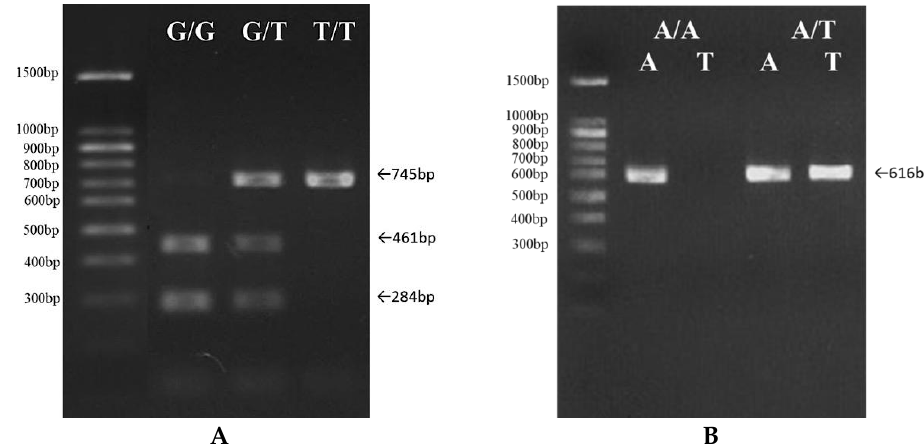
Figure 1. The detection of single nucleotide polymorphisms’ genotype distribution by ARMS-PCR. After the clean-up of PCR products, some were digested by RE, and PCR products were separated into different fragment sizes using 2% agarose gel electrophoresis to distinguish single-nucleotide variation. ( A ) Three genotypes, G/G, G/T, and T/T, in the SNP3 IFN-γ 490 gene. ( B ) Two genotypes, A/A and A/T, in the SNP19 TLR3 405 gene.